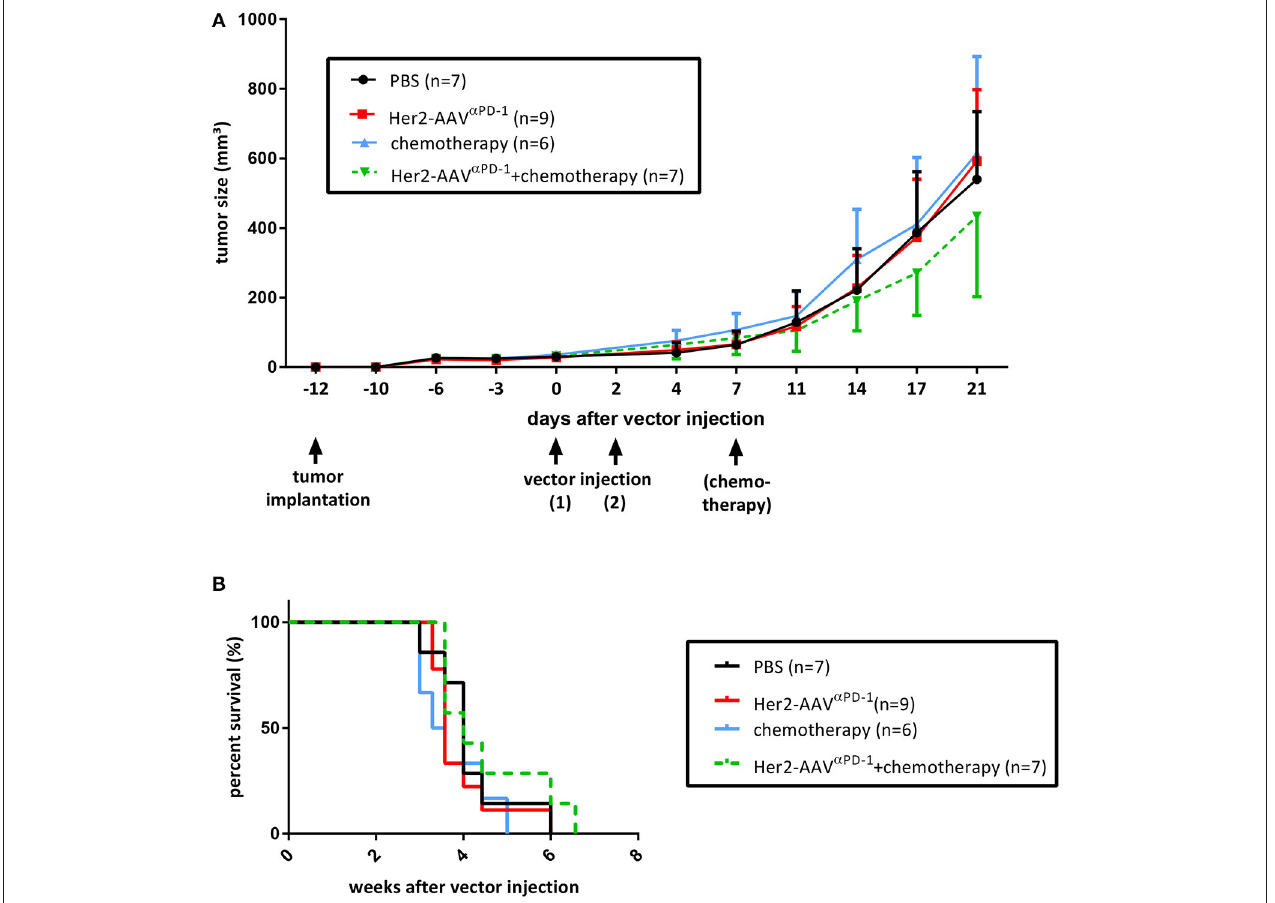
FIGURE 5 | Therapeutic approach using Her2-AAV α PD − 1 . RENCA-Her2/neu bearing BALB/c mice received two intravenous injections of Her2-AAV α PD − 1 (7 × 10 10 genome copies each), either as a monotherapy (red lines) or in combination with the chemotherapeutical agent Ixabepilone (8 mg/kg; green dotted lines). Mice that received either chemotherapy alone (8 mg/kg; blue lines) or PBS (black lines) served as controls. Tumor size was monitored using the formula 0.4 × length × width 2 . Therapy was started when tumor sizes had reached 50 mm 3 in average and mice were sacrificed when tumors were ≥ 800 mm 3 in size. (A) Tumor growth curves with first sacrificed mouse selected as end-point (mean ± SD). (B) Kaplan-Meier survival